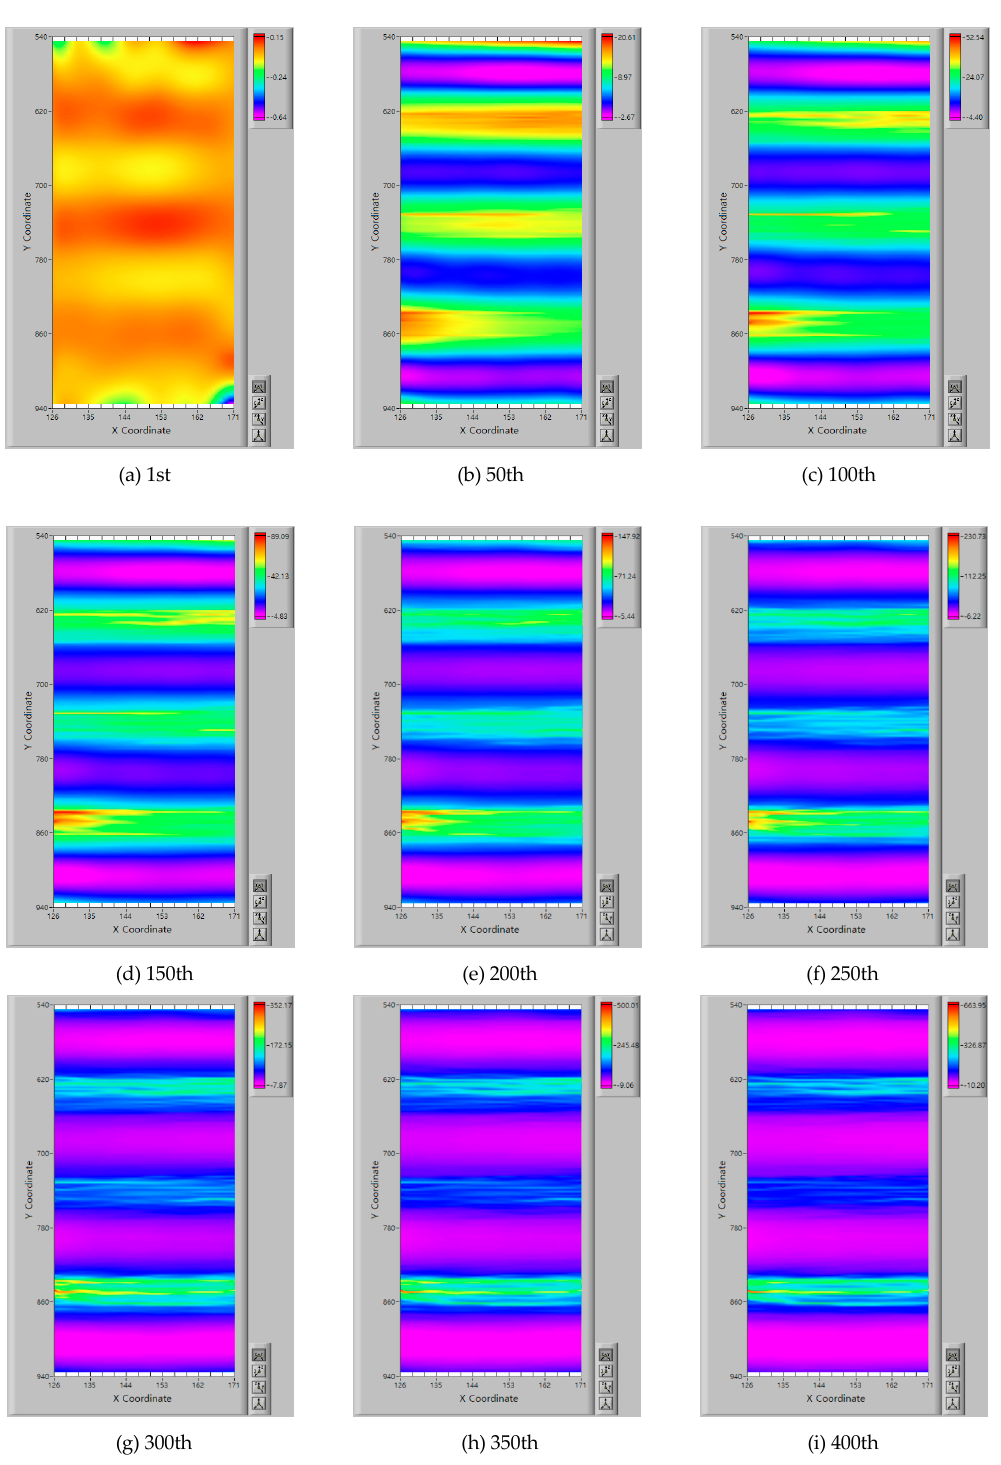
Figure 18. The Y-direction displacement gradient distributions from DIC measurement. The position of test specimen fracture was compared with the displacement gradient distribution result of the DIC method in Figure 19. The fracture picture of the specimen is shown on the right, and the DIC displacement gradient distribution image is overlapped on the test specimen